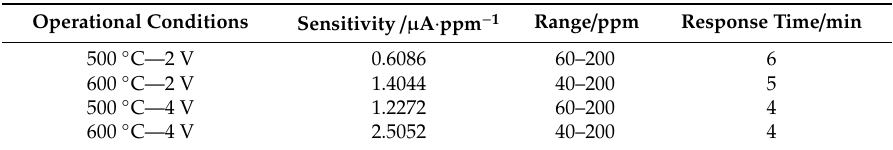
Table 2. Sensitivity results obtained from chronoamperometry tests with the BaCeZrY sensor at 500 ◦ C and 600 ◦ C and at 2 V and 4 V.